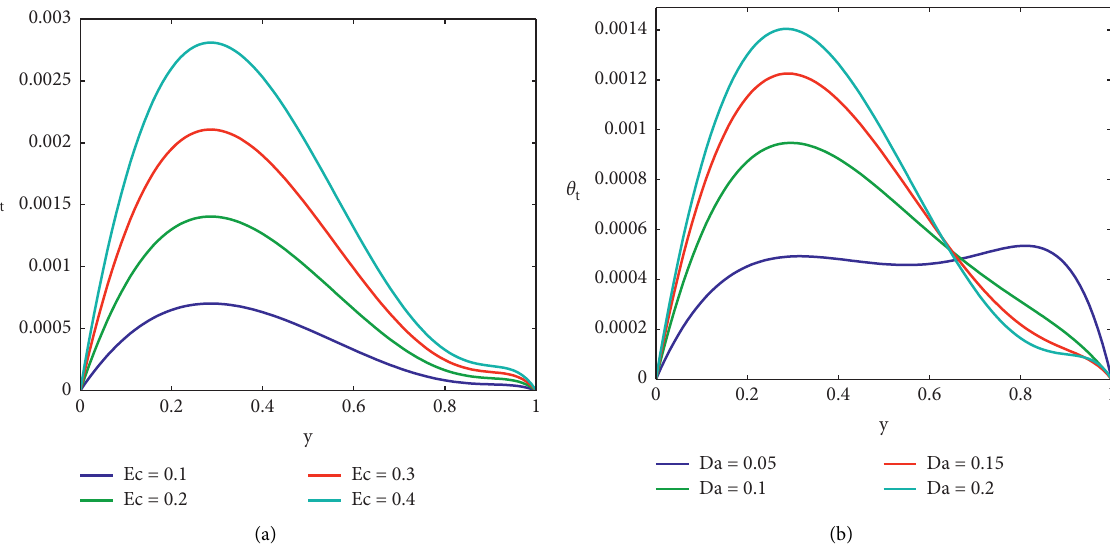
Figure 8: (a) Effect of Ec on “unsteady temperature distribution” for Da � 0 . 2. (b) Effect of Da on “unsteady temperature distribution” for Ec � 0.2.